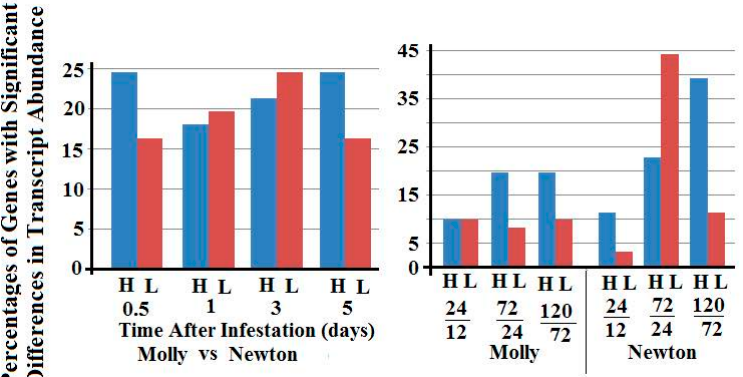
Figure 4. Percentages of 61 cytochrome P450 genes with higher (blue bars, H) and lower (red bars, L) transcript abundance between larvae feeding in resistant (Molly) and susceptible (Newton) plants at 0.5, 1, 3, and 5 days ( left panels), and between two successive stages (1 versus 0.5 day, 3 versus 1 day, and 5 versus 3 days) of Hessian fly larvae feeding in either resistant (Molly) or susceptible (Newton) plants ( right panels).